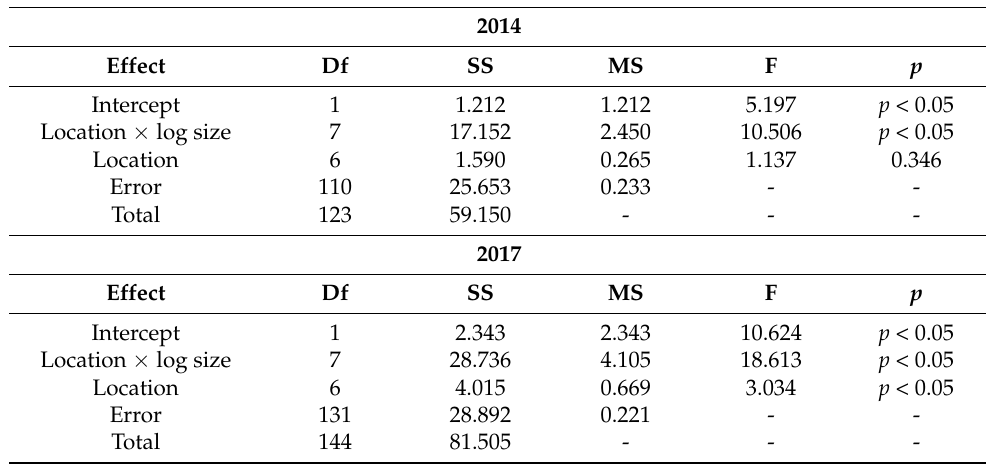
Table 3. Results of Analysis of Covariance (ANCOVA) with Separate Slopes of Absolute Fecundity (AF, log) in different locations with size (mm, log) as covariate (d.f.: estimated degrees of freedom, SS: sum of squares, MS: mean